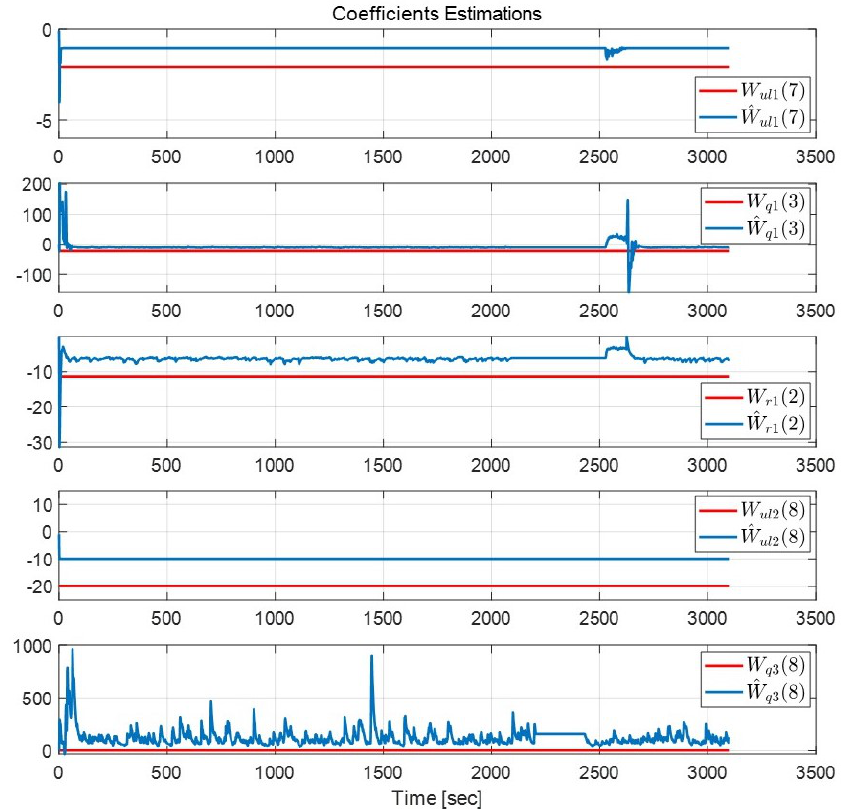
Figure 7. Some of coefficients estimations using the adaptation laws